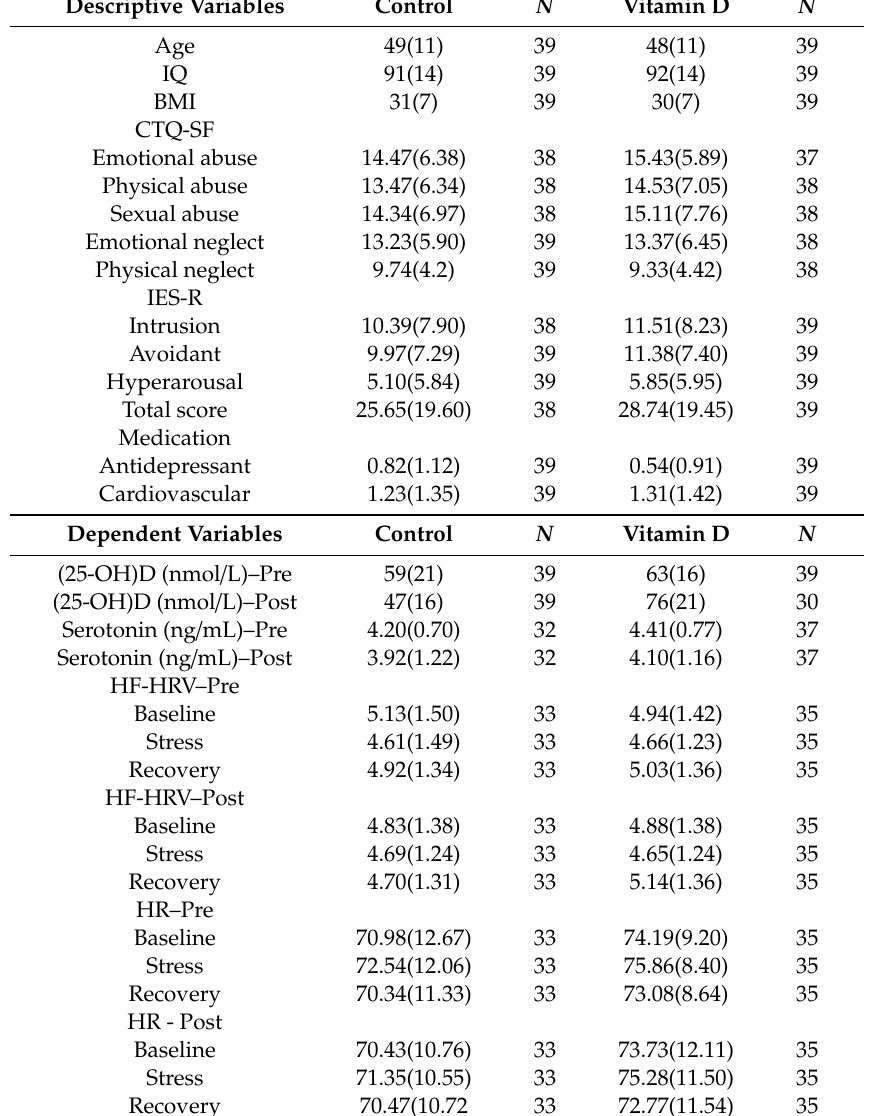
Table 2. Means and bracketed standard deviations across all variables. N = number of participants. Descriptive